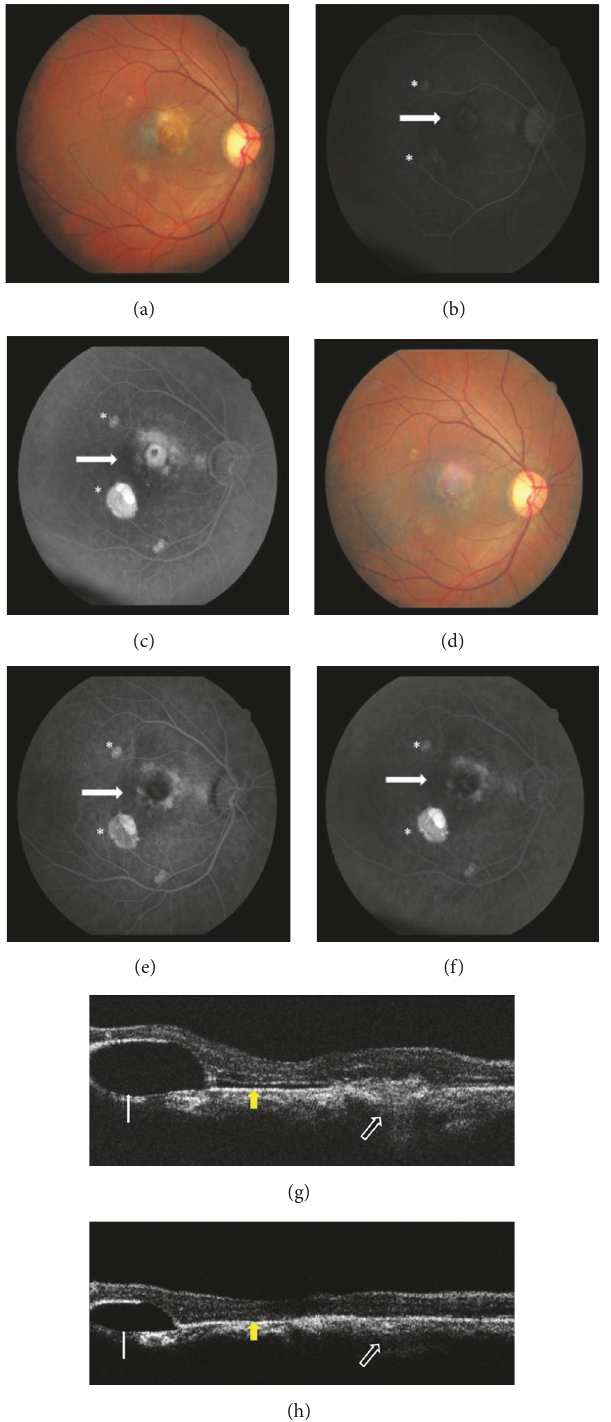
Figure 1: Right eye pre- and posttreatment fundus images, FFA and OCT scans . (a) Pretreatment color fundus image showing PED with CNVM. (b) and (c) Pretreatment FFA with 2 PEDs (asterix) and CNVM (white arrow). (d) Posttreatment color fundus image showing scarred CNVM with flattened PEDs. (e) and (f) Posttreatment FFA showing scarred CNVM with no leakage. (g) Pretreatment OCT demonstrating submacular CNVM complex (broad arrow with white borders), SRF (yellow arrow), and PED (narrow white arrow). (h) Posttreatment OCT demonstrating regressed CNVM complex (broad arrow with white borders), resolved SRF (yellow arrow), and reduced PED height (narrow white